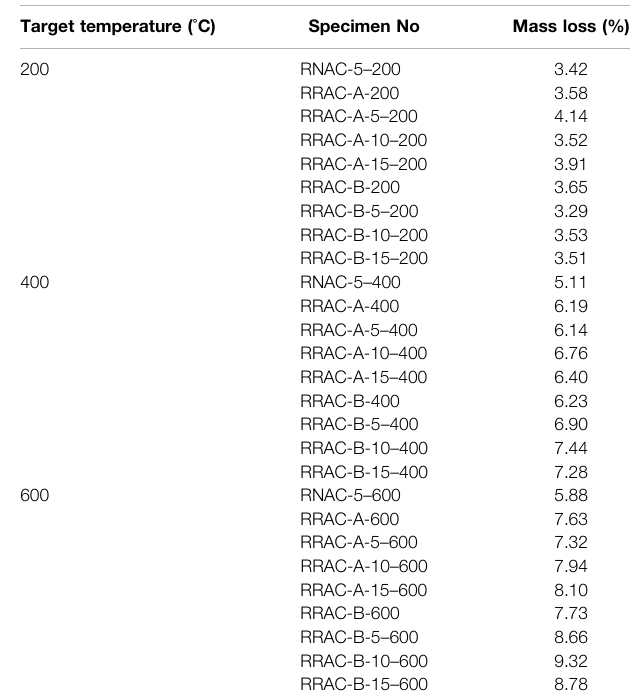
TABLE 6 | Mass loss for